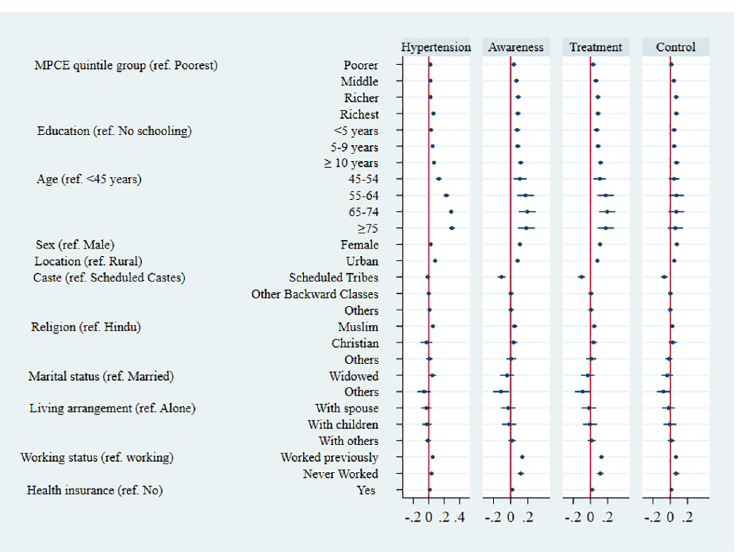
Fig 5. Averaged marginal effects on probability of hypertension and on probabilities of ATC among those with hypertension, adults aged 45 years and over and their spouses. Notes: Estimated averaged marginal effects on probability of the respective outcome from multivariable logistic regressions. Dots show point estimates. Horizontal lines show 95% CI. Numerical estimates are presented in table format in S12 Table. All regressions also include a complete set of state indicators (fixed effects) in addition to all the covariates listed in the table. Estimates of state- specific averaged marginal effects presented in S12 Table. ATC, awareness, treatment, and control; MPCE, monthly per capita consumption